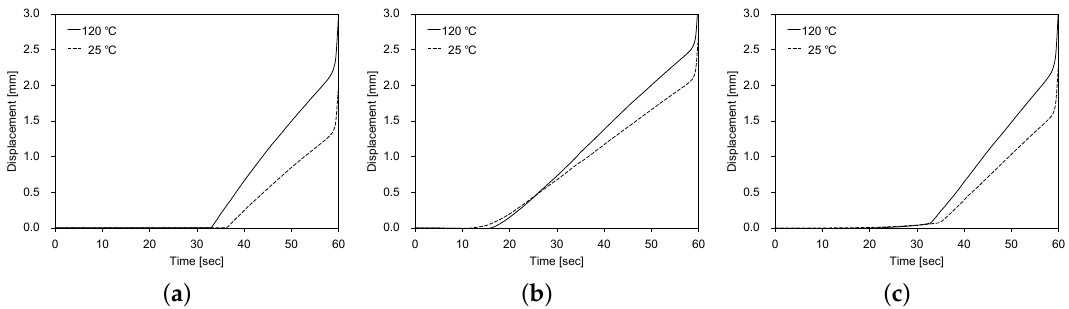
Figure 9. Spring back displacement of the polycarbonate sheet during the depressurization process in both loading cases: ( a ) center point, ( b ) midpoint of major semiaxis, and ( c ) midpoint of minor